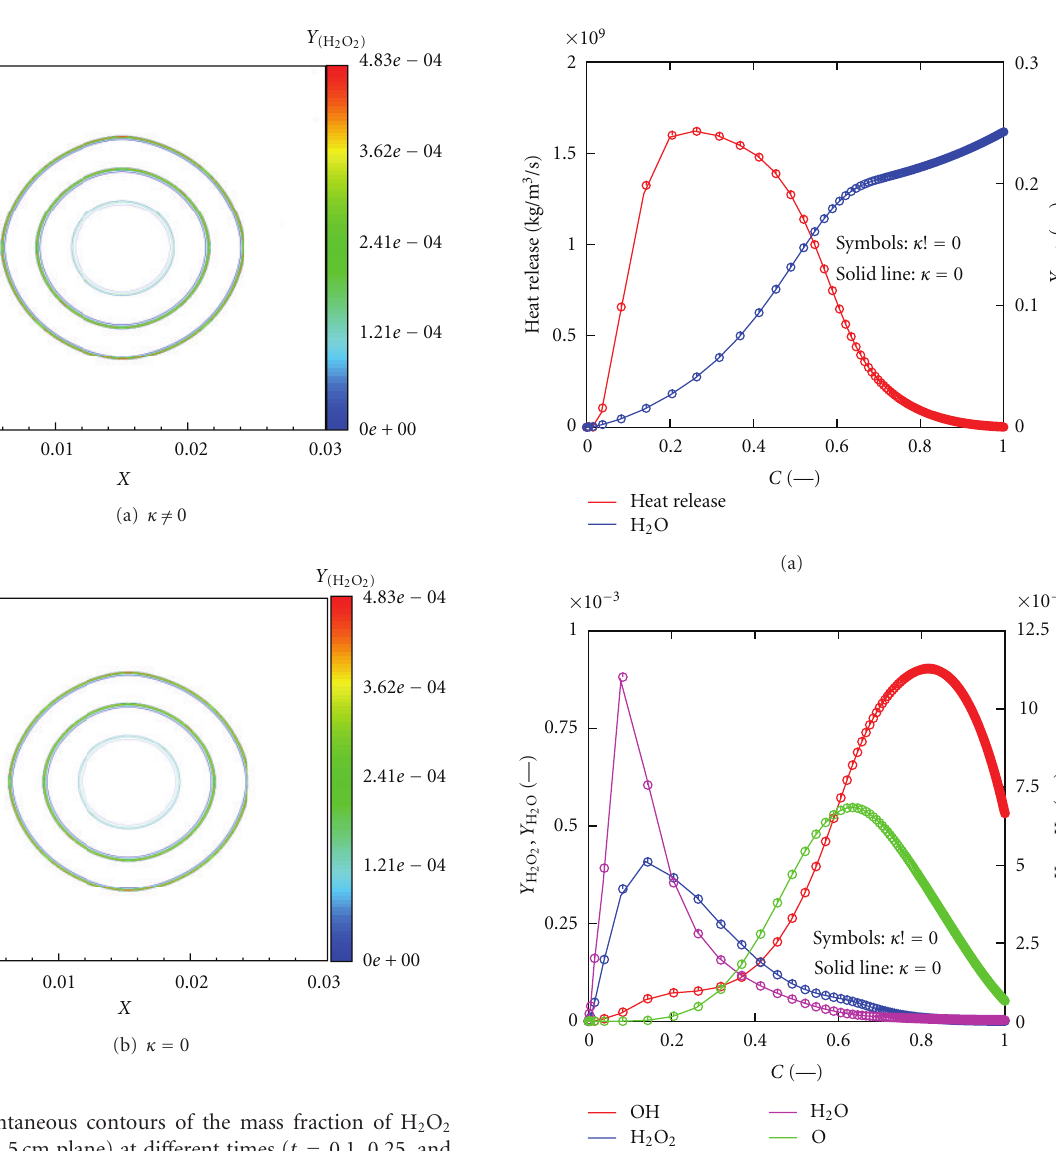
Figure 3: Instantaneous contours of the mass fraction of H 2 O 2 (along the z = 1 . 5 cm plane) at di ff erent times ( t = 0 . 1, 0.25, and 0.5 millisecond) with (a) and without (b) volume viscosity. The concentric circles correspond, respectively, to three time instances with increasing radii. Figure 4: Instantaneous profiles of laminar premixed methane-air